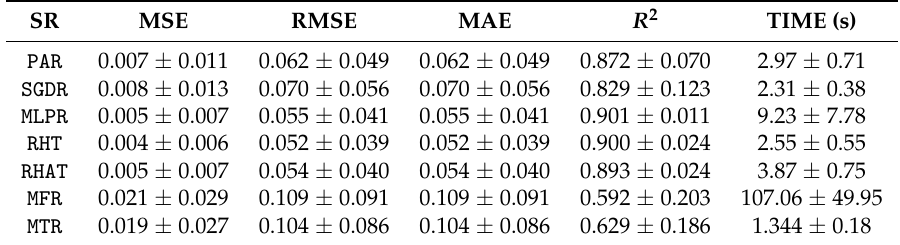
Table 3. Results of the experiment 1: variable selection with a 5% of preparatory instances. Note that RMSE = MAE because all differences are equal.